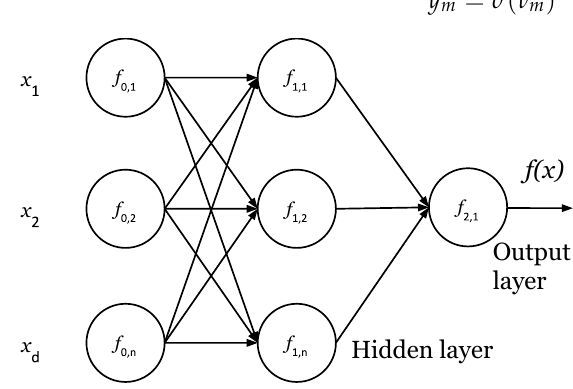
Figure 1. Example of the Multilayer Perceptron